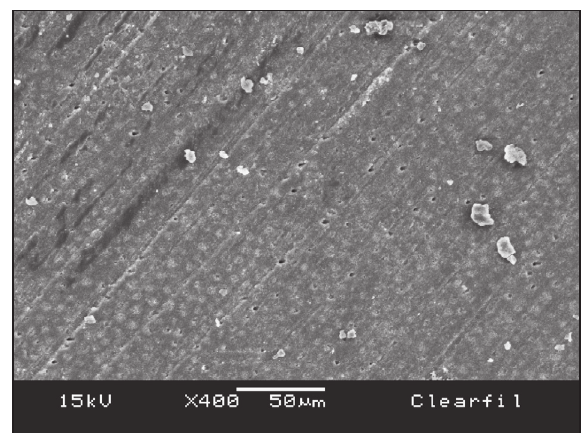
Figure 4 - Adhesive failure along the dentin surface (type 3) with absence of the self-adhesive resin (Clearfil SA Cement) over the dentin surface (original magnification 400 × ).